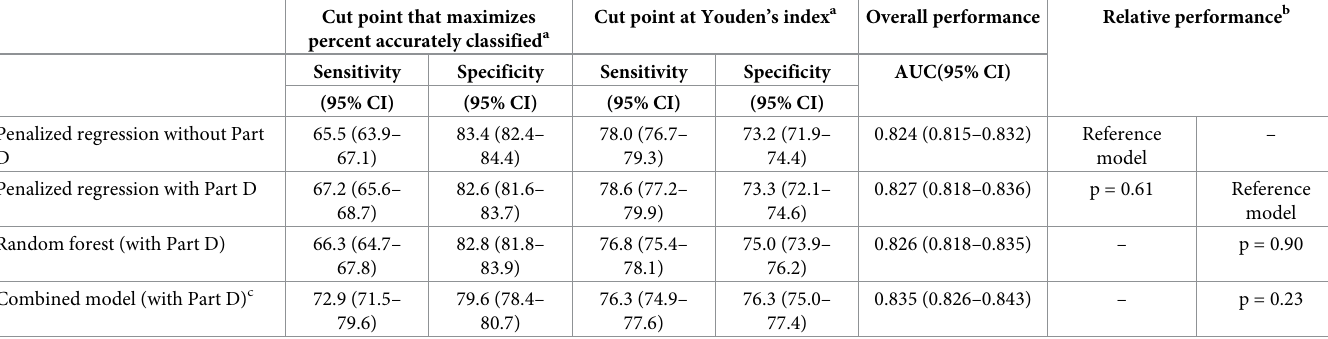
Table 2. Performance of models for predicting Parkinson disease in the test